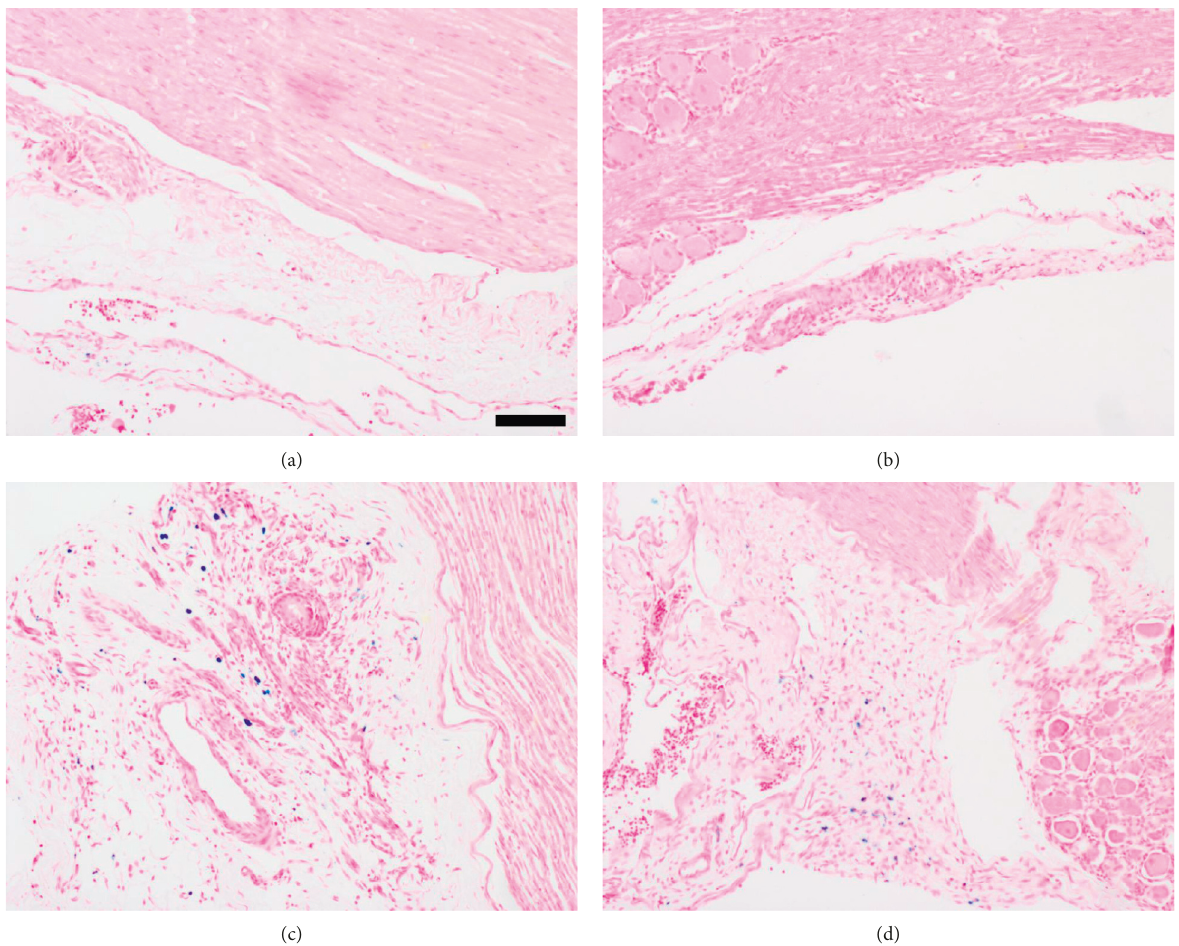
Figure 7: Prussian blue staining verifies MRI observations. Left L5 spinal nerves harvested from SNL rats after MRI show increased iron staining in the perineural tissues, compared to the corresponding tissues in sham rats ( n � 2 per group; iron: blue, nuclei: red, and cytoplasm: pink; scale bar � 100 μ m). (a) Sham 1. (b) Sham 2. (c) SNL 1. (d) SNL